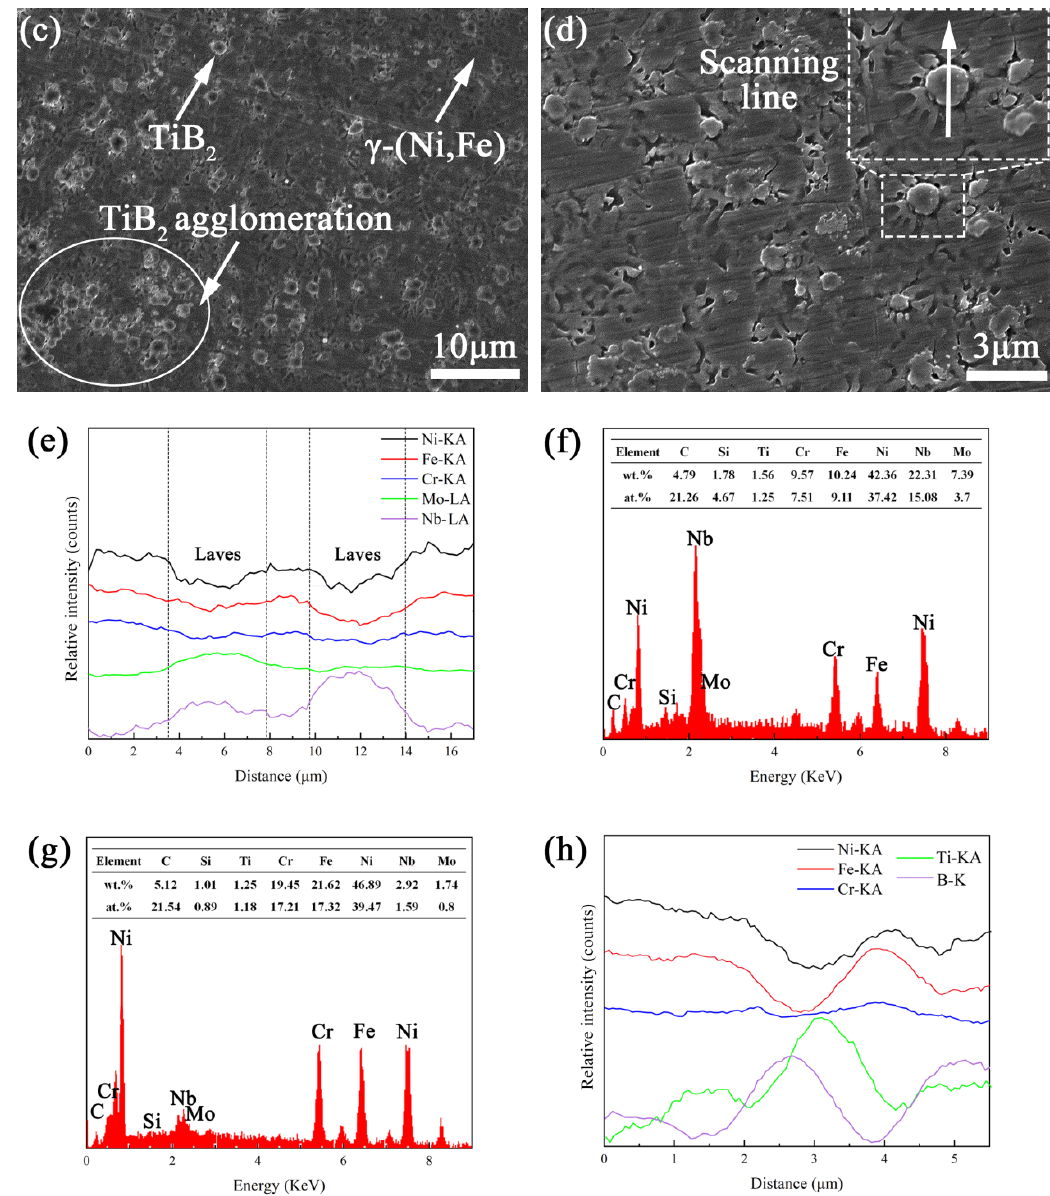
Figure 8. SEM images of the microstructure of coatings ( a , b ) TB0 and ( c , d ) TB10, ( e ) EDS line scan of Laves and, EDS energy spectra of ( f ) Laves and ( g ) γ -(Ni, Fe), ( h ) EDS line scan of TiB 2 particle